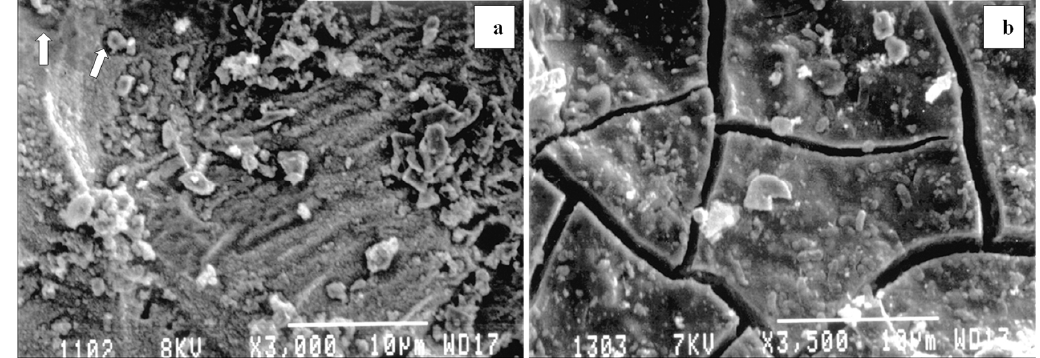
(scale bars: 10 µ m). Surface corrosion by microbes was observed in the experiment (see arrows on ( a ) effluents with low pH. In the presence of the CPMW coatings with classical desiccation cracks in